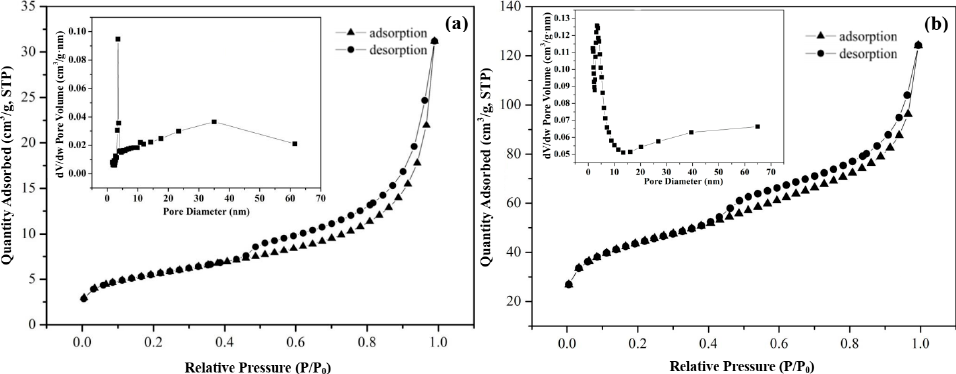
Figure 4. N 2 adsorption/desorption isotherms of ( a ) raw Dt and ( b ) CS-modified Dt (Inserts are pore diameter distributions). Table 1. Comparison of Brunauer–Emmett–Teller (BET) surface area and BJH (Barrett–Joyner–Halenda) average pore diameter of raw Dt and CS-modified Dt.